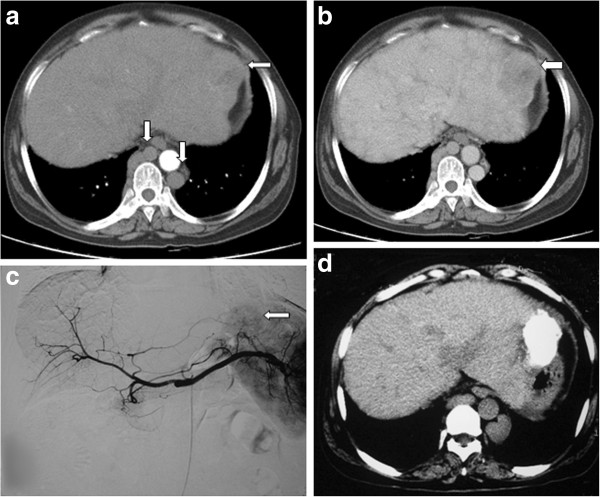
51-year-old woman with HCC in BCS. (a) Contrast-enhanced transverse CT scan showing a large mild heterogeneous enhanced nodule(⇦) in the left liver during arterial phase and obvious cirsoid azygous vein and semi-azygous vein (⇩) and liver congestive cirrhosis. (b) Washout of the nodule on portal venous phase (⇦). (c) Angiography showing heterogeneous and contorted tumorous veins in the left liver (⇦) during arterial phase. TACE was given at the first time. (d) Contrast-enhanced transverse CT scan showing that the nodule was obtained stable effect after 2 TACE treatments for 14 months. Lipiodol was located equably in the nodule.